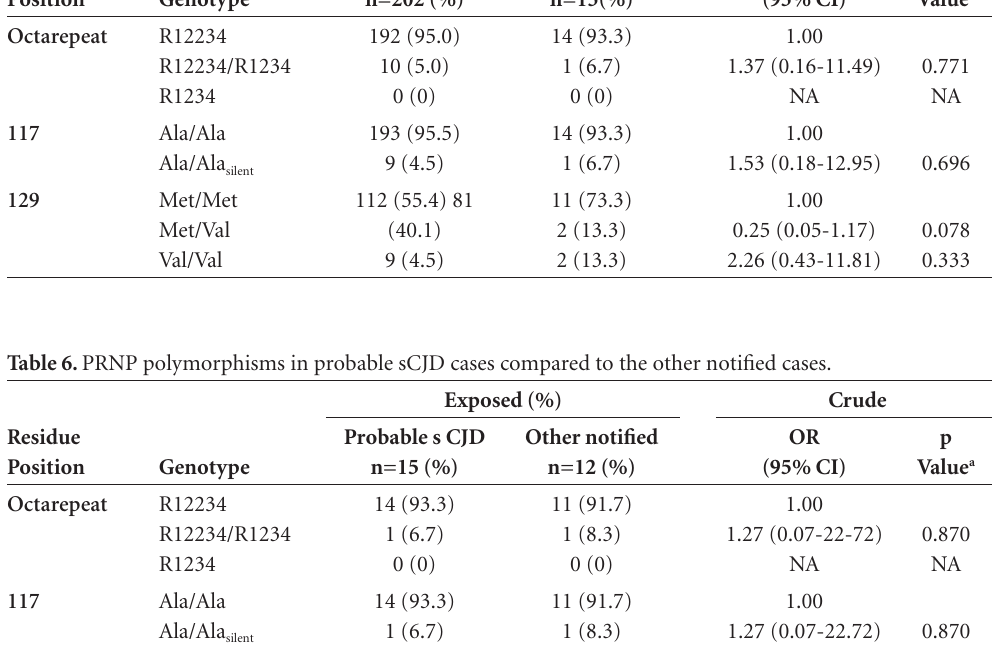
Table 5. PRNP polymorphisms in probable sCJD cases compared to the controls. Residue Position Octarepeat